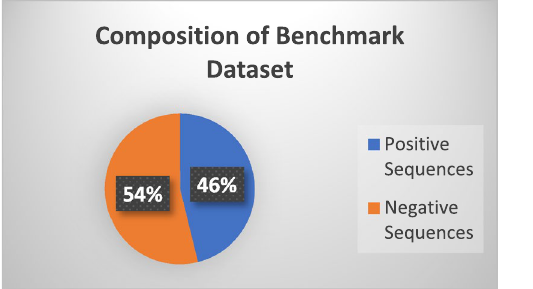
Figure 2. Ratio of positive AND negative